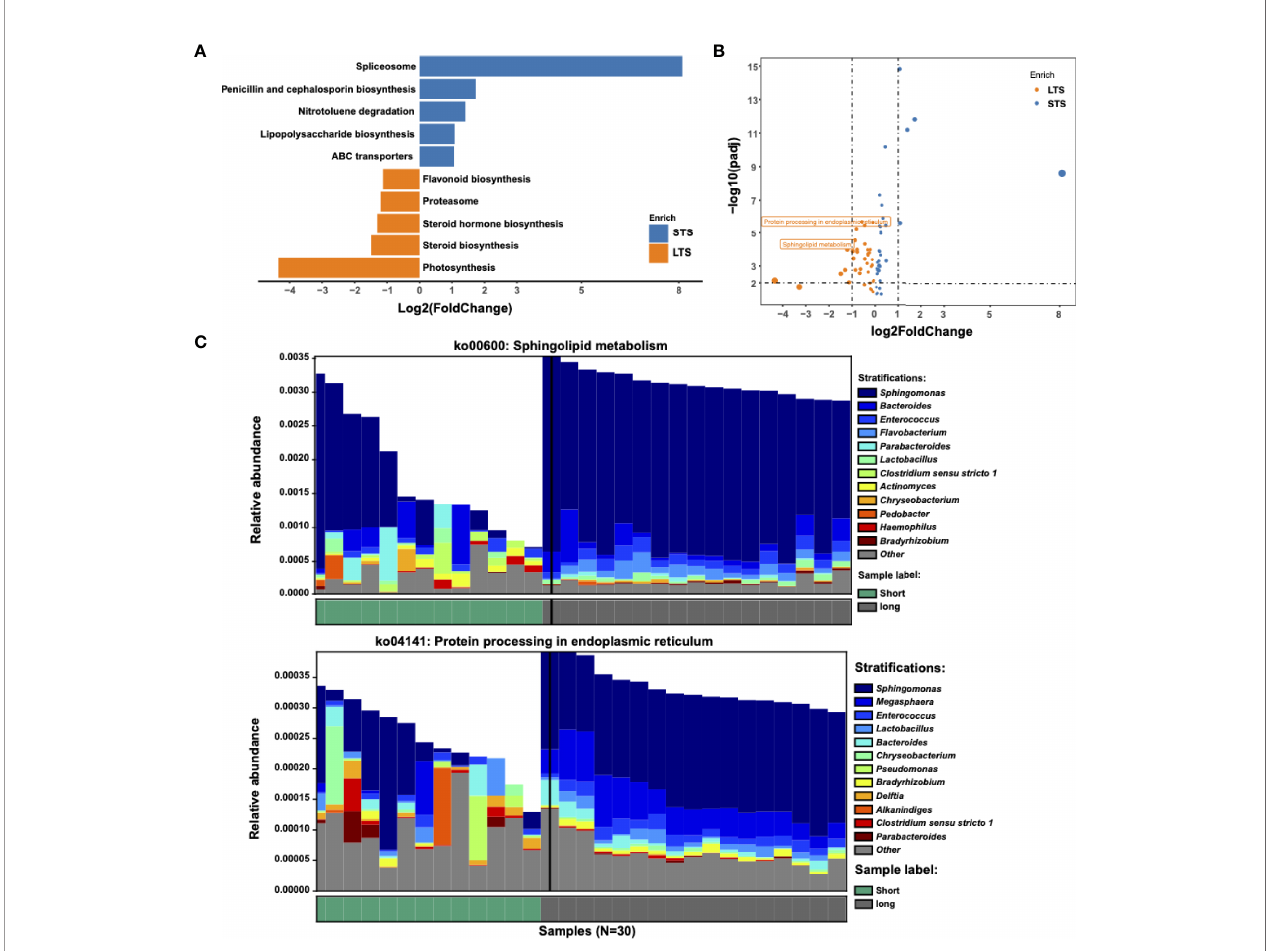
FIGURE 3 | Metabolic pathways driven by microbial communities from LTS and STS patients. (A) KEGG pathway analysis was performed. Signi fi cantly differential KEGG pathways (p<=0.01 and |log 2 fold change|>=1) are presented. For each KEGG pathway, the bar shows the fold-enrichment of the pathway. (B) Volcano plot of KEGG pro fi les between LTS and STS patients. (C) Contribution of bacterial species to 2 different pathways in 13 STS and 17 LTS